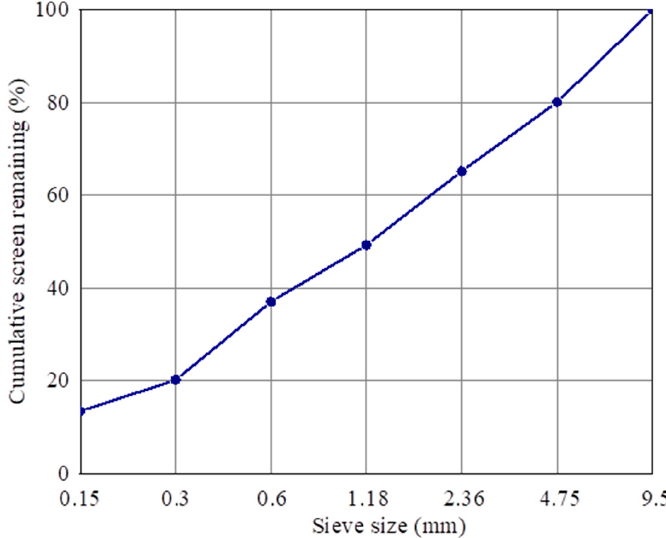
Figure 2. Gradation curve of recycled aggregate particles.